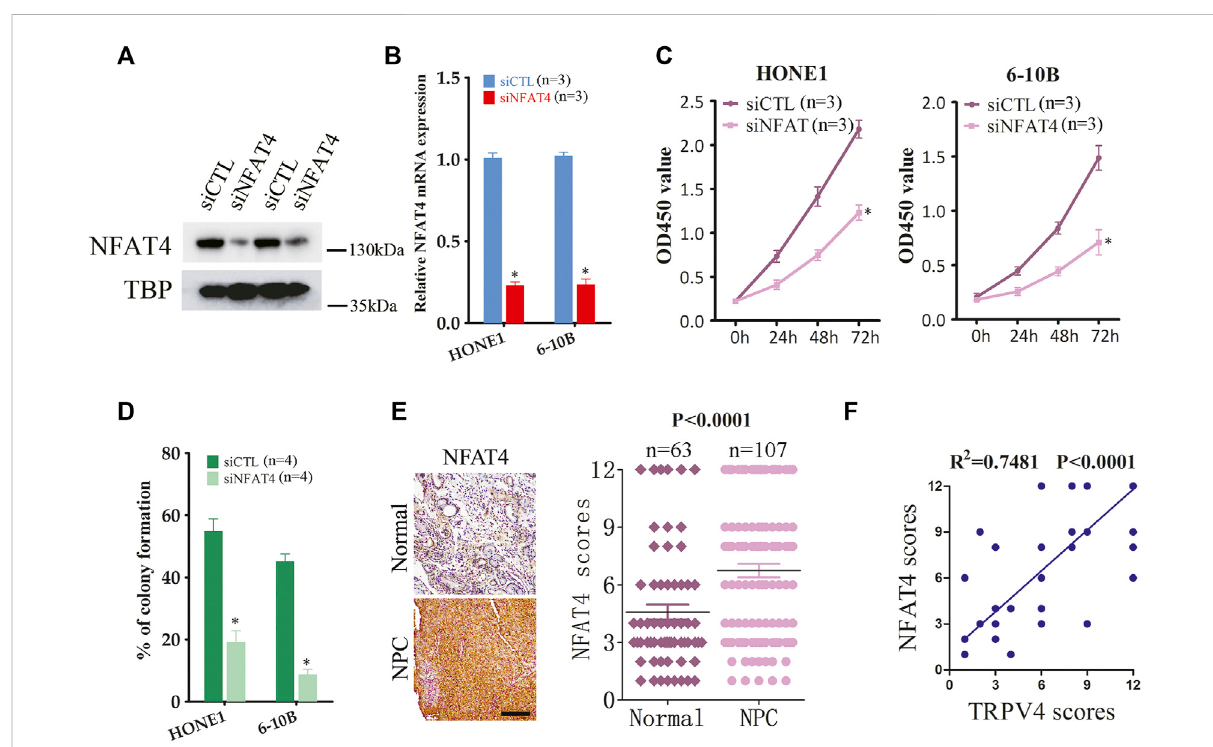
FIGURE 6 NFAT4 regulates the growth of NPC cells (A,B) NFAT4 protein and mRNA expression in NPC cells transfected with control siRNA (siCTL) or NFAT4 siRNA(siNFAT4) (n = 3). (C) Proliferation rates of thecontrol and NFAT4-knockdown NPC cells (n = 3). (D) Number ofcolonies formed bythe control and NFAT4-knockdown NPC cells (n = 4). (E) Representative images and scores of NFAT4 protein expression in normal (n = 63) and NPC tissues (n = 107). Scare bar = 100 μ m. (F) Pearson correlation of NFAT4 and TRPV4 expression levels, R 2 = 0.7482 means that ~75% variation in NFAT4proteinexpressioncanbeexplainedbyTRPV4proteinexpression,orthePearson ’ scorrelationbetweenNFAT4andTRPV4isR=0.8649.The data represent the mean ± SEM. * p < 0.05, versus